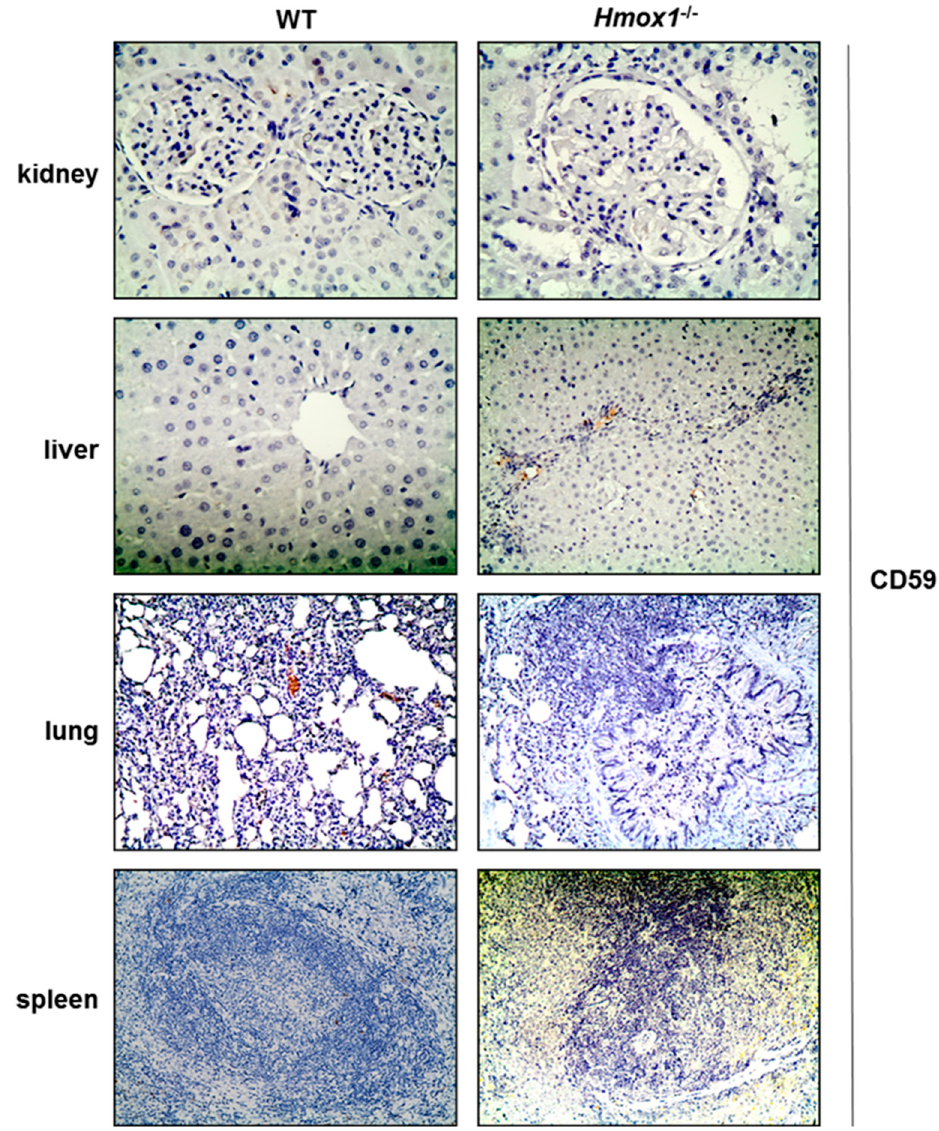
Figure 3. CD59 immunostaining of WT and Hmox1 − / − rat tissue sections. CD59 was undetectable in all tissues examined. Magnification ×200.